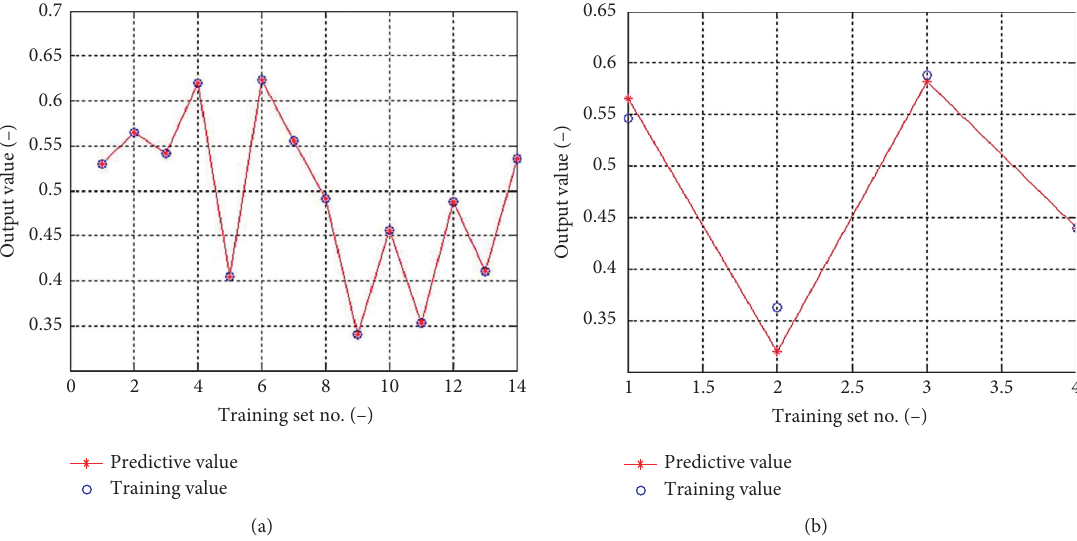
Figure 6: Predictive accuracy of the pavement friction coefficient based on BP neural network. (a) Comparison between the predictive set value and the training set value. (b) Comparison between the predictive set value and the testing set value. Table 9: The precision test for the predictive model of the pavement friction